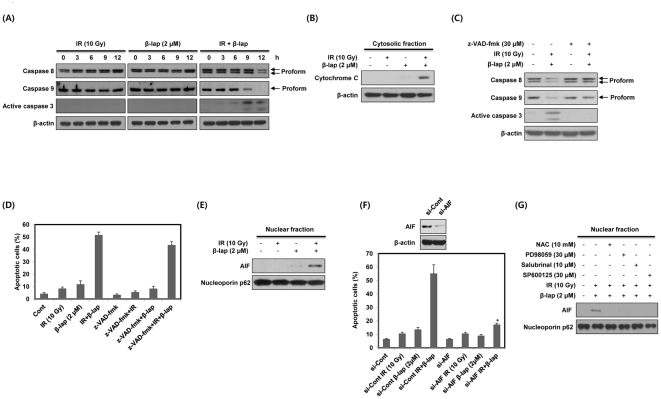
β-lap in combination with IR induces apoptotic cell death via nuclear translocation of AIF.(A) NQO1+-MDA-MB-231 cells were treated with IR alone, β-lap alone or combination of IR and β-lap for the indicated times. The data represent a typical experiment conducted three times with similar results. (B) NQO1+-MDA-MB-231 cells were treated with IR alone, β-lap alone or combination of IR and β-lap for 12 h. Cytosolic fractions from NQO1+-MDA-MB-231 cells were prepared and subjected to Western blot analysis. The data are representative a typical experiment conducted three times. The data represent a typical experiment conducted three times with similar results. (C) NQO1+-MDA-MB-231 cells were treated with combination of IR and β-lap for 12 h in the presence or absence of z-VAD-fmk. The data represent a typical experiment conducted three times with similar results. (D) NQO1+-MDA-MB-231 cells were treated with IR alone, β-lap alone or combination of IR and β-lap for 24 h in the presence or absence of z-VAD-fmk (30 µM). After 24 h, the percentage of the cells with sub-G1 DNA content was determined by flow cytometry. Results from three independent experiments are expressed as means ± SEMs. (E) NQO1+-MDA-MB-231 cells were treated with IR alone, β-lap alone or combination of IR and β-lap for 24 h. Nuclear fractions from NQO1+-MDA-MB-231 cells were prepared and subjected to Western blot analysis. The data are representative a typical experiment conducted three times. (F) NQO1+-MDA-MB-231 cells were treated with IR alone, β-lap alone or combination of IR and β-lap for 24 h in the presence or absence of siRNA targeting AIF. After 24 h, the percentage of the cells with sub-G1 DNA content was determined by flow cytometry. Results from three independent experiments are expressed as means ± SEMs. (G) NQO1+-MDA-MB-231 cells were treated with combination of IR and β-lap for 24 h in the presence or absence of NAC, PD98059, Sal or SP600125. Nuclear fractions were prepared and subjected to Western blot analysis. The data are representative a typical experiment conducted three times.